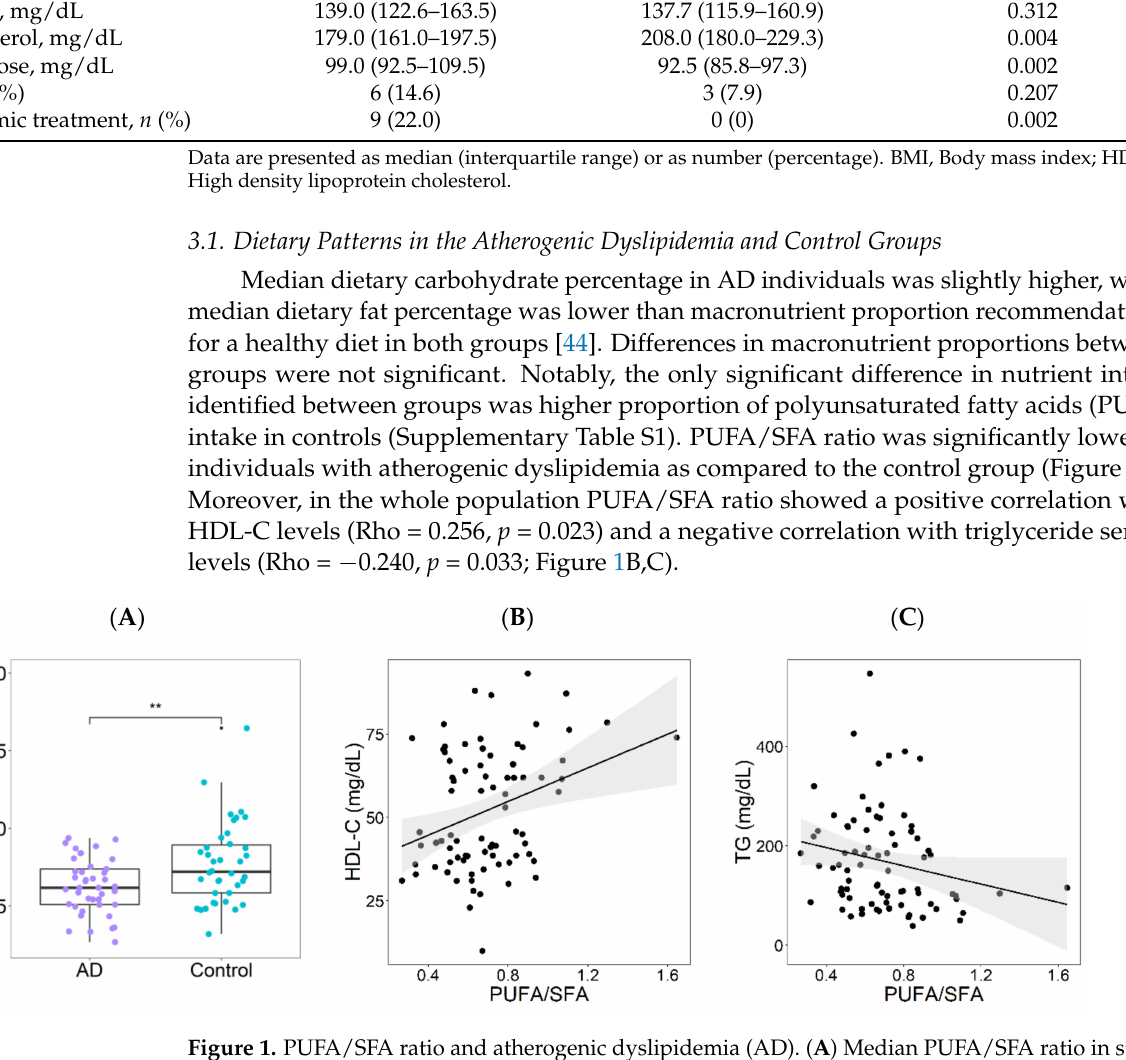
Figure 1. PUFA/SFA ratio and atherogenic dyslipidemia (AD). ( A ) Median PUFA/SFA ratio in study groups. ( B ) Spearman correlation between HDL-C serum levels and PUFA/SFA ratio including the whole study population (Rho = 0.256; p = 0.023). ( C ) Spearman correlation between TG serum levels and PUFA/SFA ratio (Rho = − 0.240; p = 0.033). PUFA, polyunsaturated fatty acids; SFA, saturated fatty acids; HDL-C, high density lipoprotein -cholesterol; TG triglycerides. ** p <